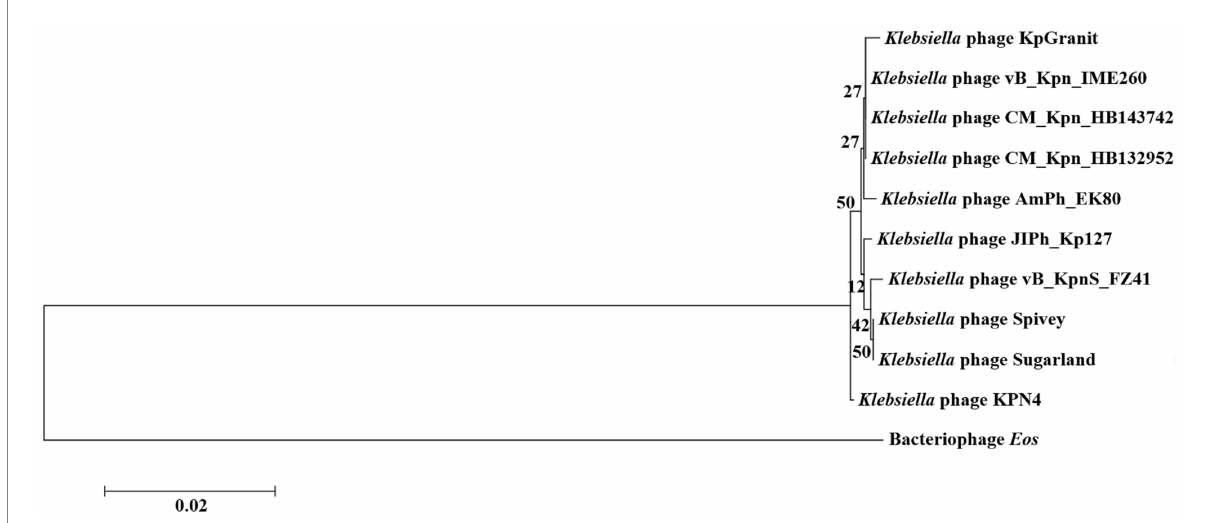
FIGURE 6 Phylogenetic relationships of phage CM_Kpn_HB132952 and CM_Kpn_HB143742. Phylogenetic tree of phage CM_Kpn_HB132952 and CM_Kpn_ HB143742 constructed based on DNA polymerase. The horizontal direction represents the degree of change of genetic variables, and the branches in the horizontal direction represent the changes of evolutionary lineages over time. The longer the branch length, the greater the change of the corresponding species of the branch. The scale is equal to 0.02, indicating that a branch of this length represents a genetic variability of 0.02 for the genome. Branch lengths represent gene sequence similarity. The number on the branch represents the Bootstrap value for that